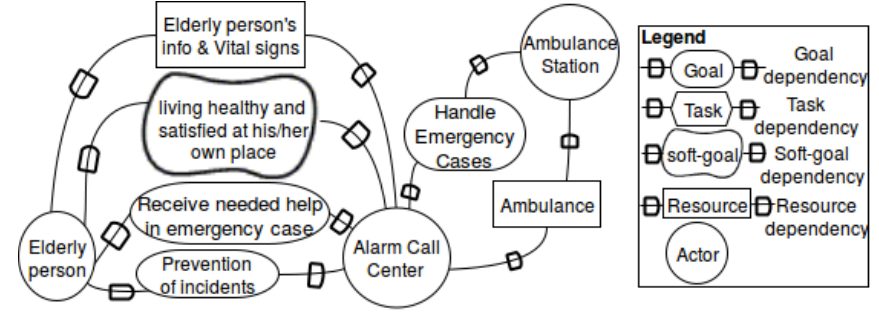
Figure 7. Simplified Strategic Dependency Model (SDM) with the dependencies between identified participants. Step 3.